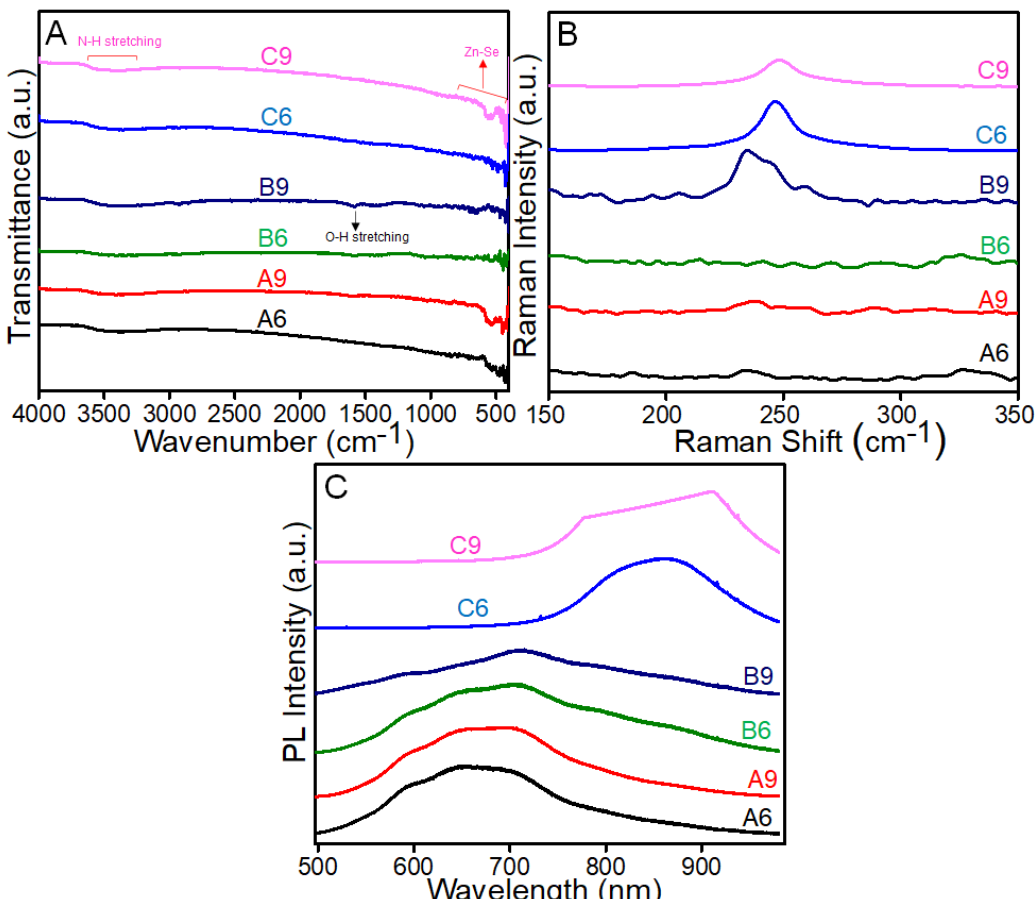
Figure 3. FTIR spectra of ZnSe nanostructures ( A ), Raman spectra ( B ) and PL spectra ( C ) of syn- thesized ZnSe nanostructures.